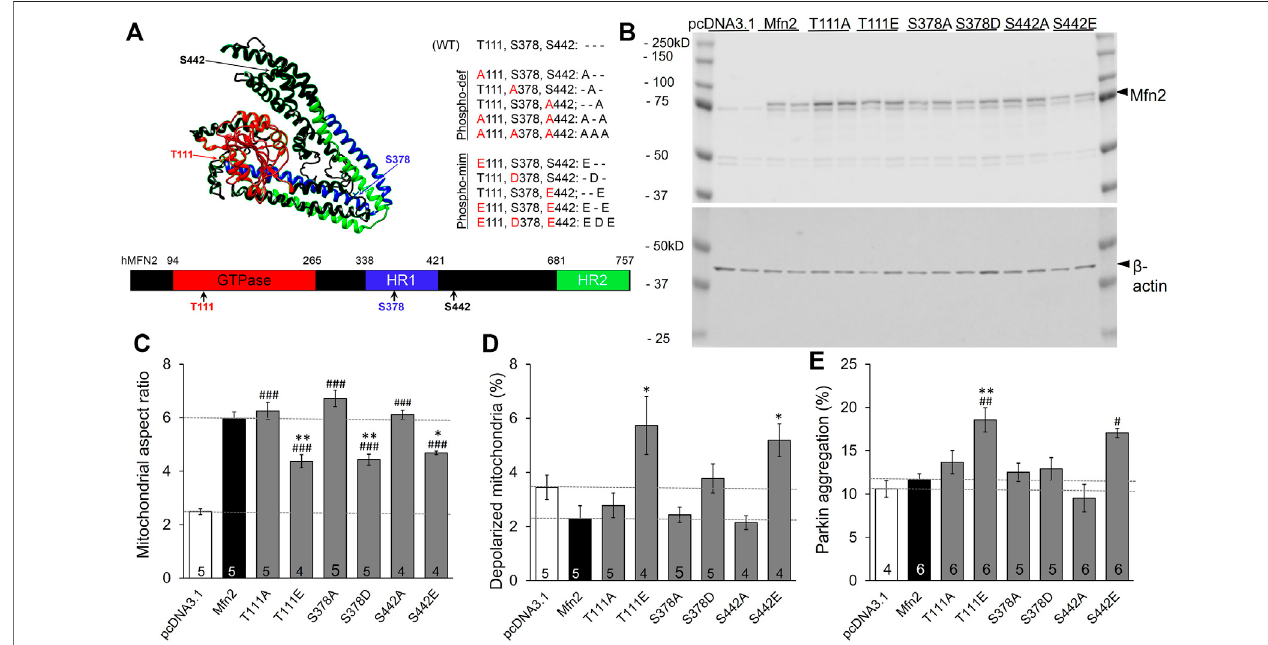
FIGURE1| EffectsofindividualPINK1phosphorylationsitestatusonMFN2-modulatedmitochondrialendpoints. (A) 3D(top)and2D(bottom)depictionsofhuman MFN2 and the positions of validated PINK1 phosphorylation sites. Domains are color coded. To the right are contemplated phospho-de fi cient (-def) and phospho- mimetic (-mim) engineered mutants. (B) Immunoblot analysis of MFN2 PINK1 phosphorylation site mutant expression in transfected HEK293 cells. Results from two independent transfections are shown. The MFN2 amino terminal FLAG epitope, which does not alter MFN2 functioning (Gong et al., 2015), slightly retards SDS- PAGE mobility of the expressed proteins compared to endogenous HEK293 MFN2. (C – E) . Change in mitochondrial aspect ratio (C) , depolarization (D) and Parkin recruitment (E) in HEK293 cells transfected with PINK1 phosphorylation site mutants. Empty pcDNA3.1 plasmid is negative control; wild-type MFN2 is positive control (dashedlines).Nshownisnumberofindependentexperiments,eachaveragingresultsfrom6-30cells.Mutantvs.WTMfn2: p < 0.05*; p < 0.01**; p < 0.001***;Mutant vs. pcDNA3.1: p < 0.05 #; p < 0.01 ##; p < 0.001 ###, all by ANOVA. Error bars are SEM.